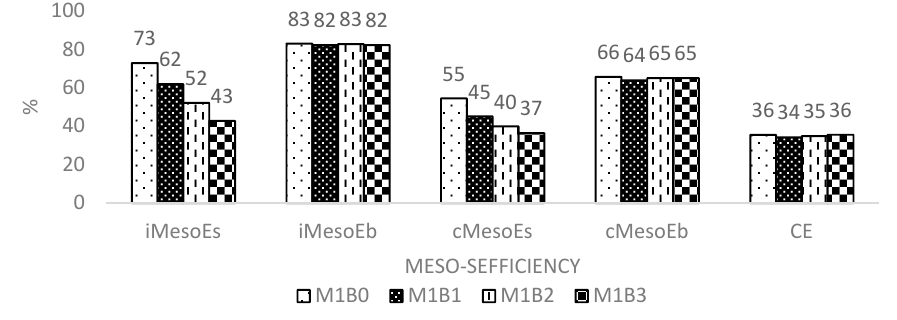
Figure 12. Sefficiency for M1B. F igure 12. Sefficiency for M1B.